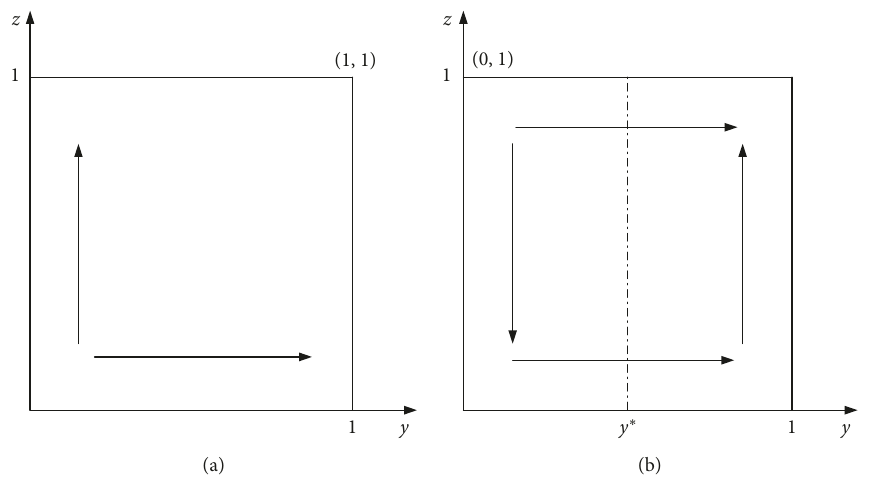
Figure 4: Dynamic evaluation diagram of strategies between external investors and SMEs. (a) v